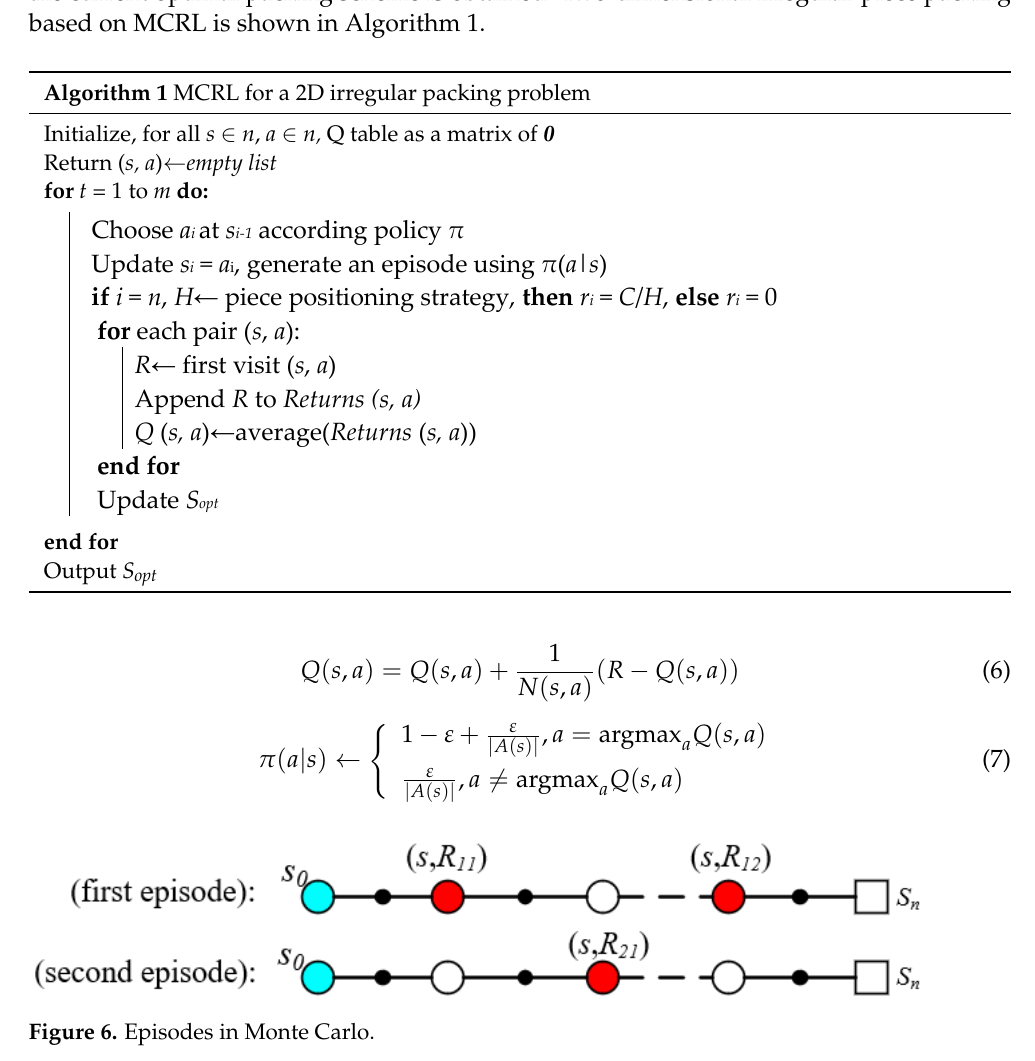
Algorithm 1 MCRL for a 2D irregular packing problem